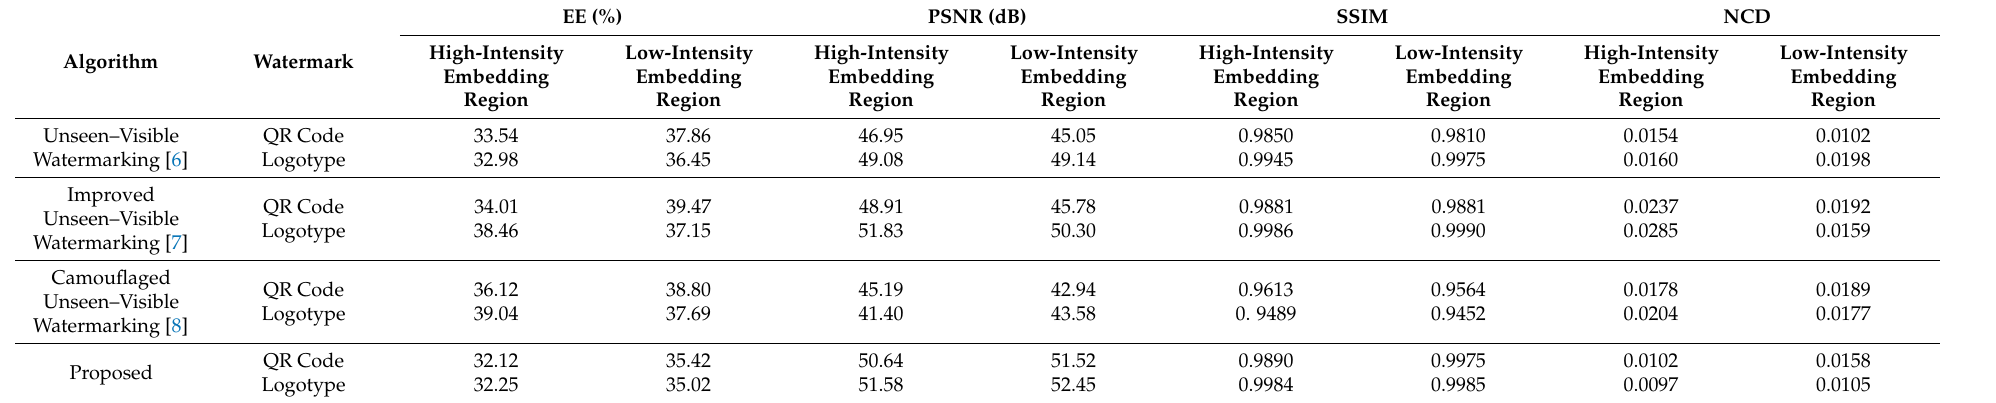
Table 4. Comparison of embedding error, quality and imperceptibility.